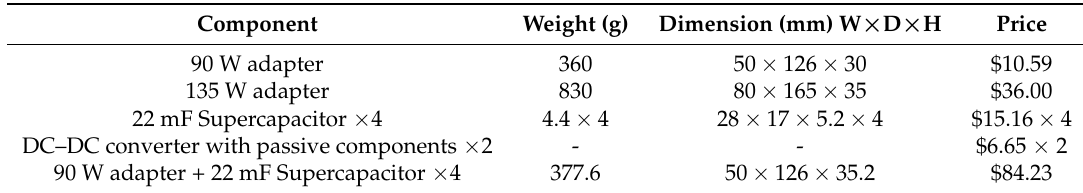
Table 3. Comparison of weight, dimensions, and price of adapters and